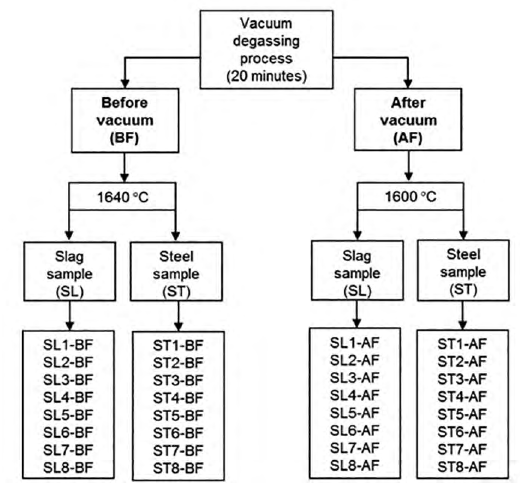
Figure 1. Sample process in the steelmaking